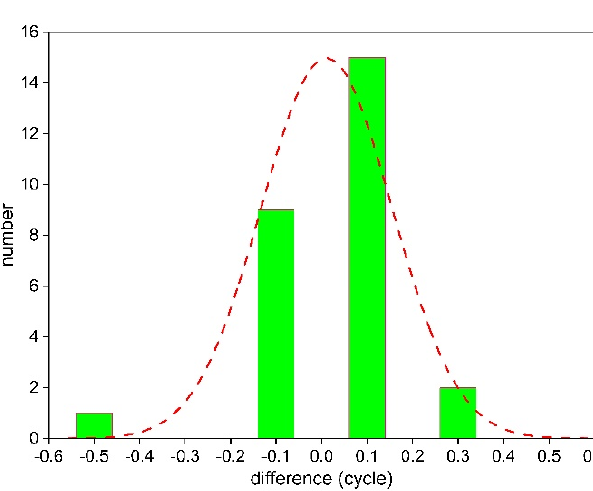
Figure 13. Statistics of difference between float solution and true value for cycle slip.